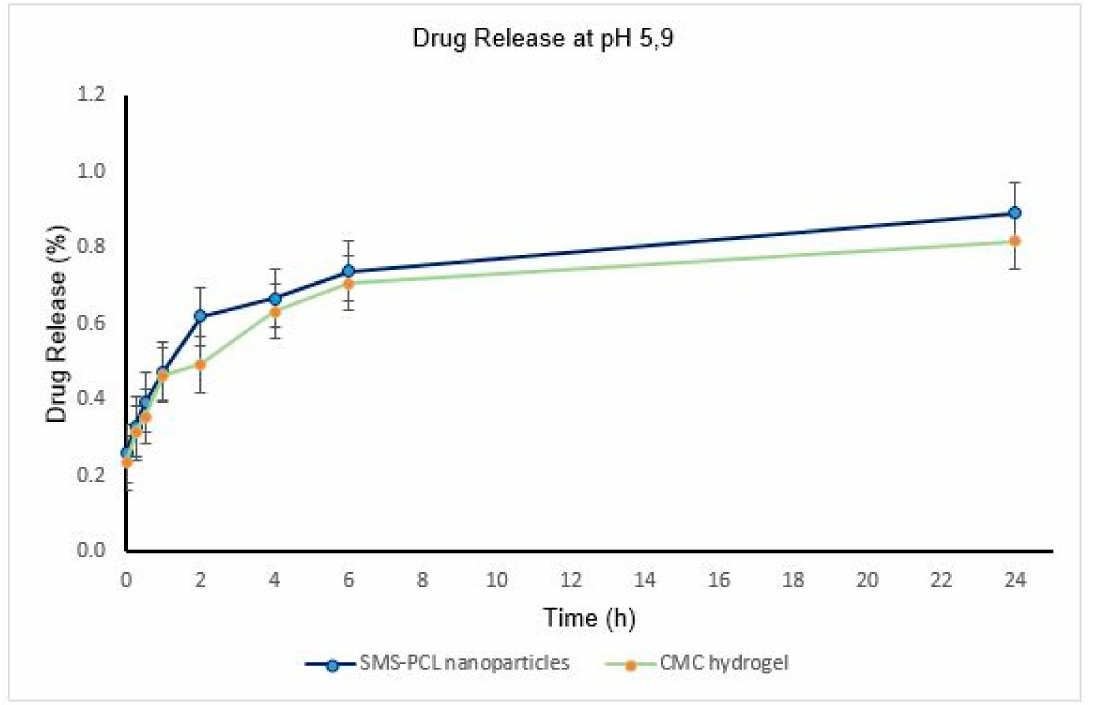
Figure 8. HCT release profiles from SMS-PCL nanoparticles and CMC hydrogel, at simulated normal skin pH (pH 5.9) at 37 ◦ C over a period of 24